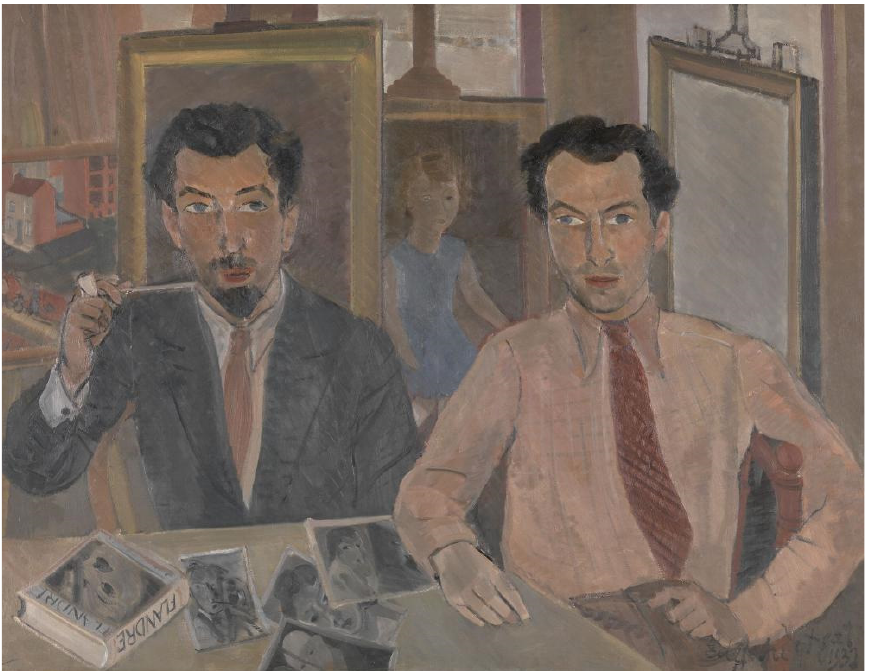
Figure 1. Edgard Tytgat, Portrait of Paul and Luc Haesaerts , 1931, oil on canvas, Collection MSK Gent © SABAM Belgium 2021.